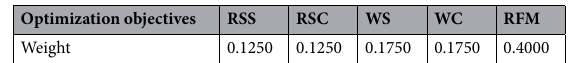
Table 9. The weights of optimization objectives.